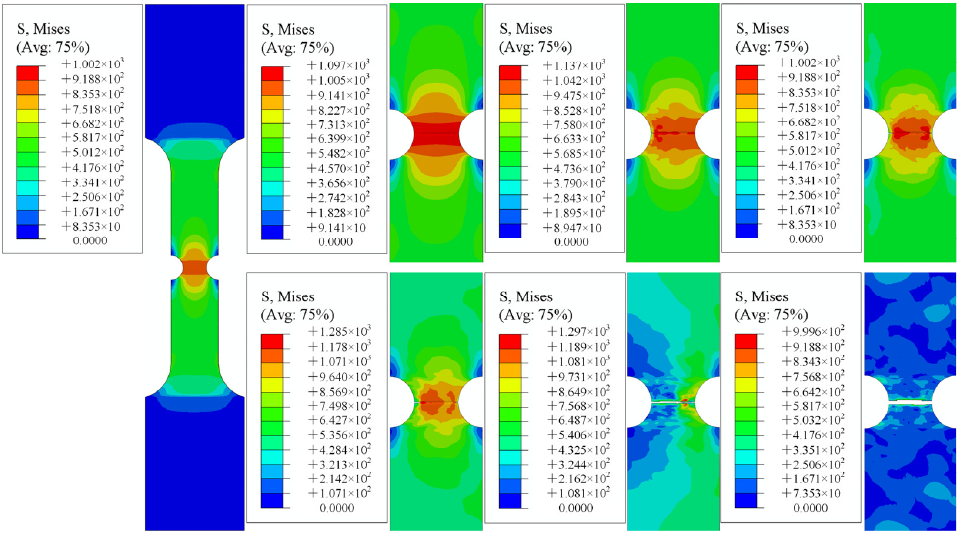
Figure 15. Notch specimen 1 (R = 2.5 mm).